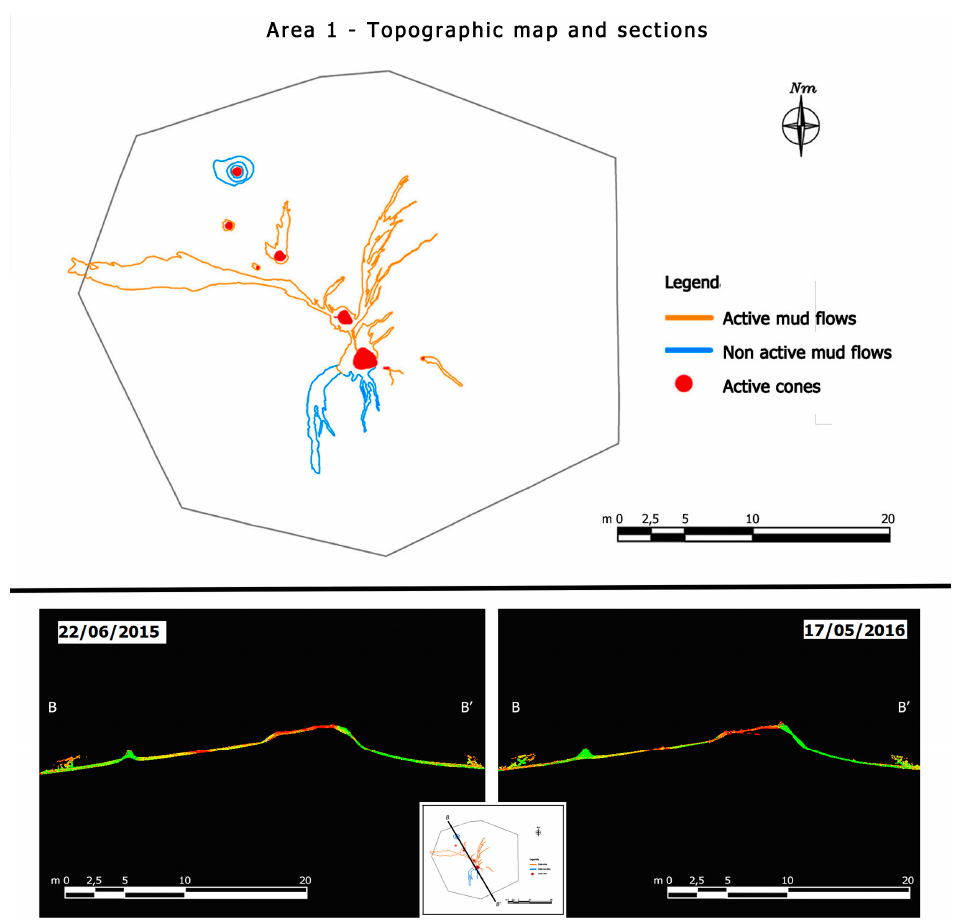
Figure 5. Topographic map and sections of one of the three main volcanic fields derived from digitization of point clouds.